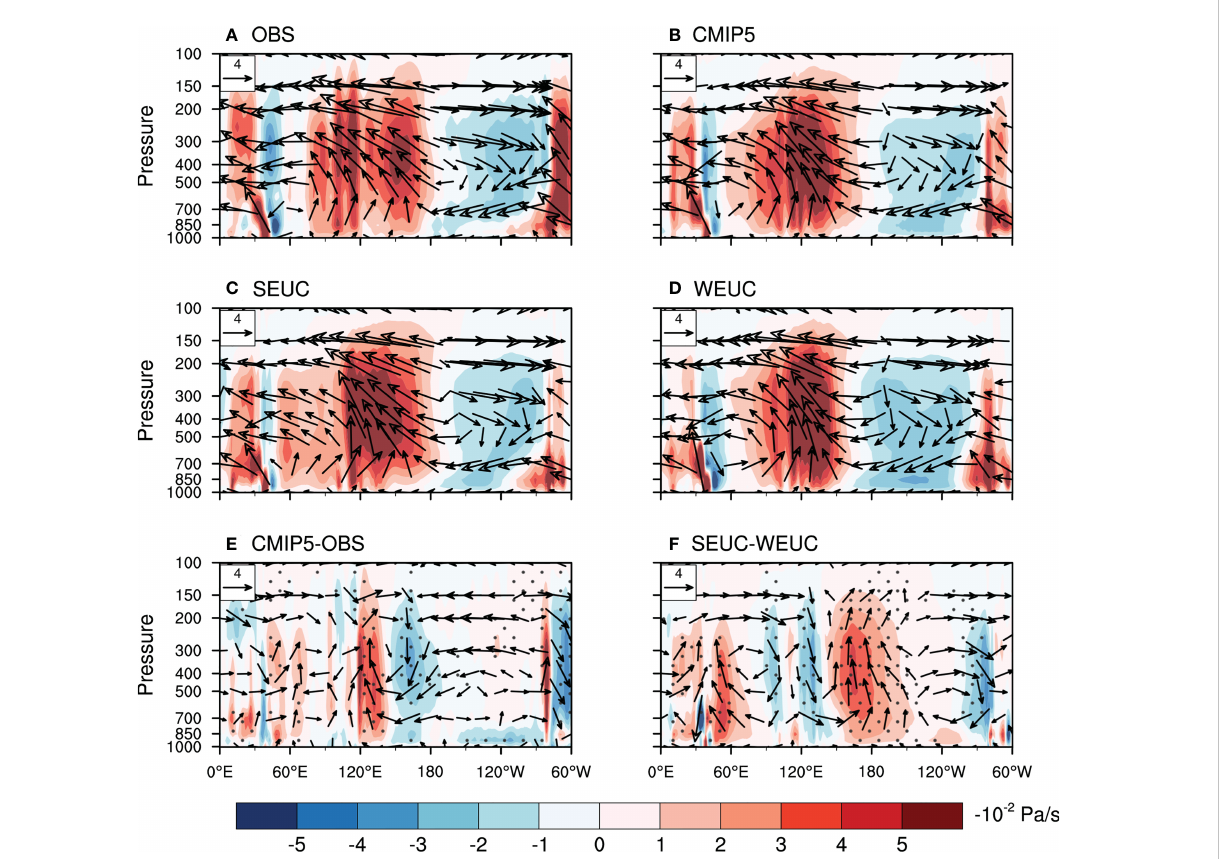
FIGURE 11 JFM mean zonal wind and pressure velocity (vectors; m/s for zonal wind and − 10 − 2 Pa/s for pressure velocity) averaged over the equatorial Paci fi c (2° S – 2° N) based on (A) the observations, (B) the MME of the CMIP5 models, (C) the composite of SEUC group, (D) the composite of the WEUC group, (E) the differences between the CMIP5 models and the observations, and (F) the differences between the SEUC and WEUC groups. Shading denotes the pressure velocity (multiplied by a factor of − 100 for clarity). Gray dots in (E) indicate the locations over which >70% of models agree on the same sign of the pressure velocity biases. Gray dots in (F) denote the signals above the 90% signi fi cance